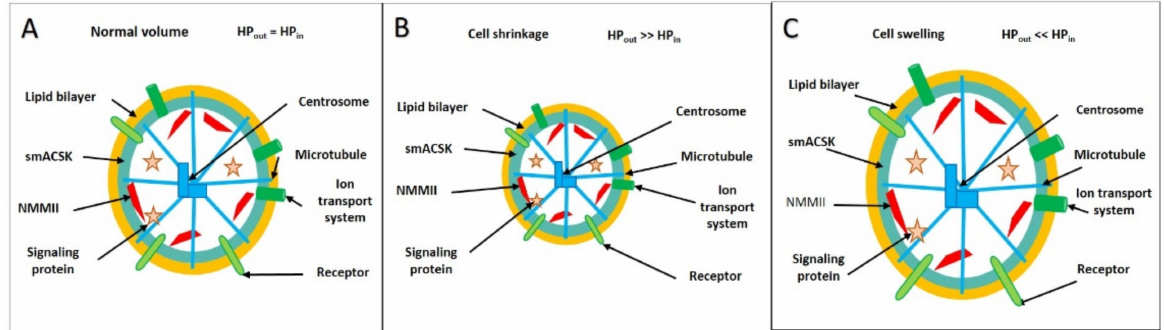
Figure 5. ( A – C ). Key players of cell volume sensing and regulation are NMMII (red dashes), the PM (yellow circle) together with the smACSK (blue-green circle) form the PM-smACSK complex, signaling proteins (red asters), cell surface receptors (green ovals) and ion transport systems (dark-green figures). The centrosome-based microtubular CSK (blue figures) forms the bulk CSK. Under normal cell volume, there is an equilibrium of hydrostatic pressure in the cell (HP in ) and in the surrounding milieu (HP out ) so that the shape of any local patch of the PM-smACSK can be assumed as planar ( A ). Under cell shrinkage, the PM-smACSK is being pulled into the cell ( B ). Under cell swelling, the PM-smACSK is being pushed into the extracellular space ( C